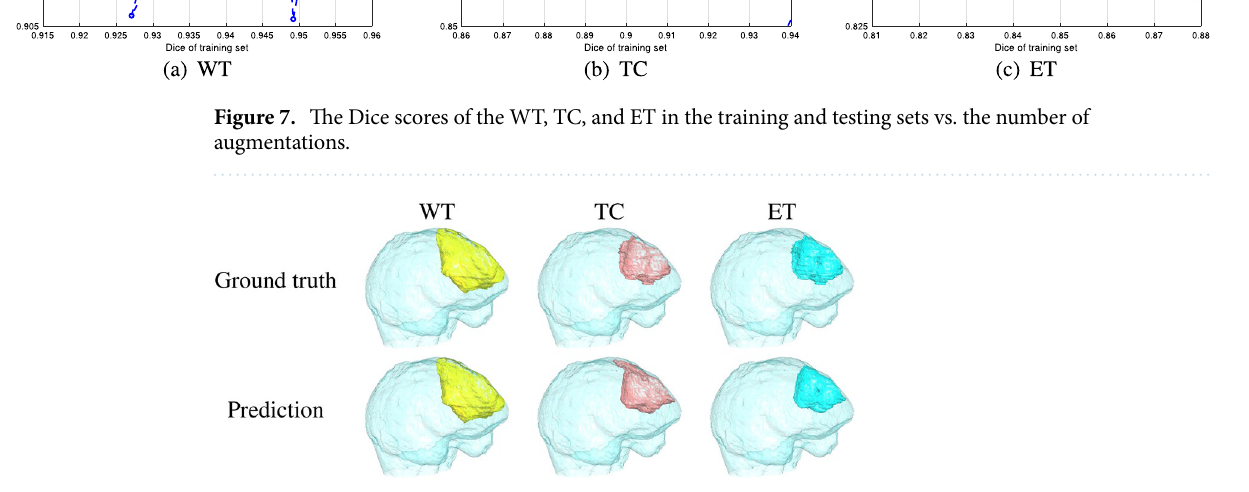
Figure 8. The ground truths and predictions for the WT (yellow), TC (red) and ET (blue) of case no. 410 with the best WT case (Dice score =